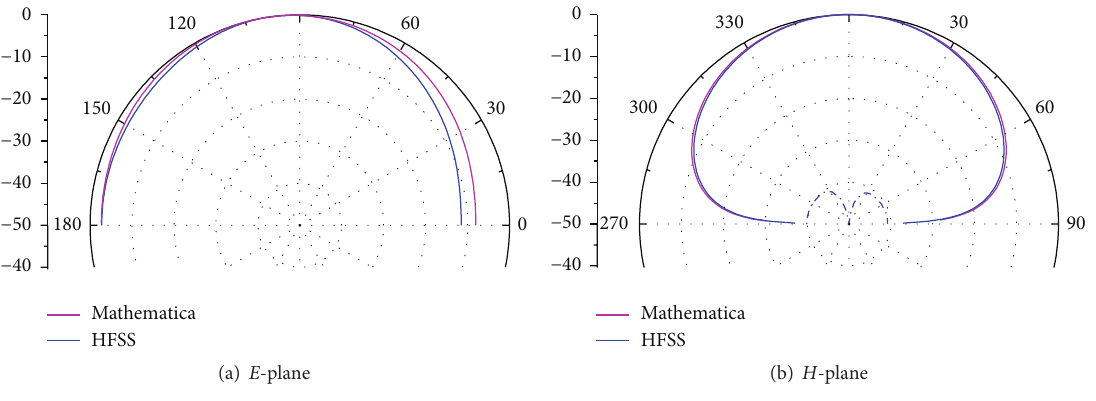
Figure 4: Radiation patterns of CBHM antennas.